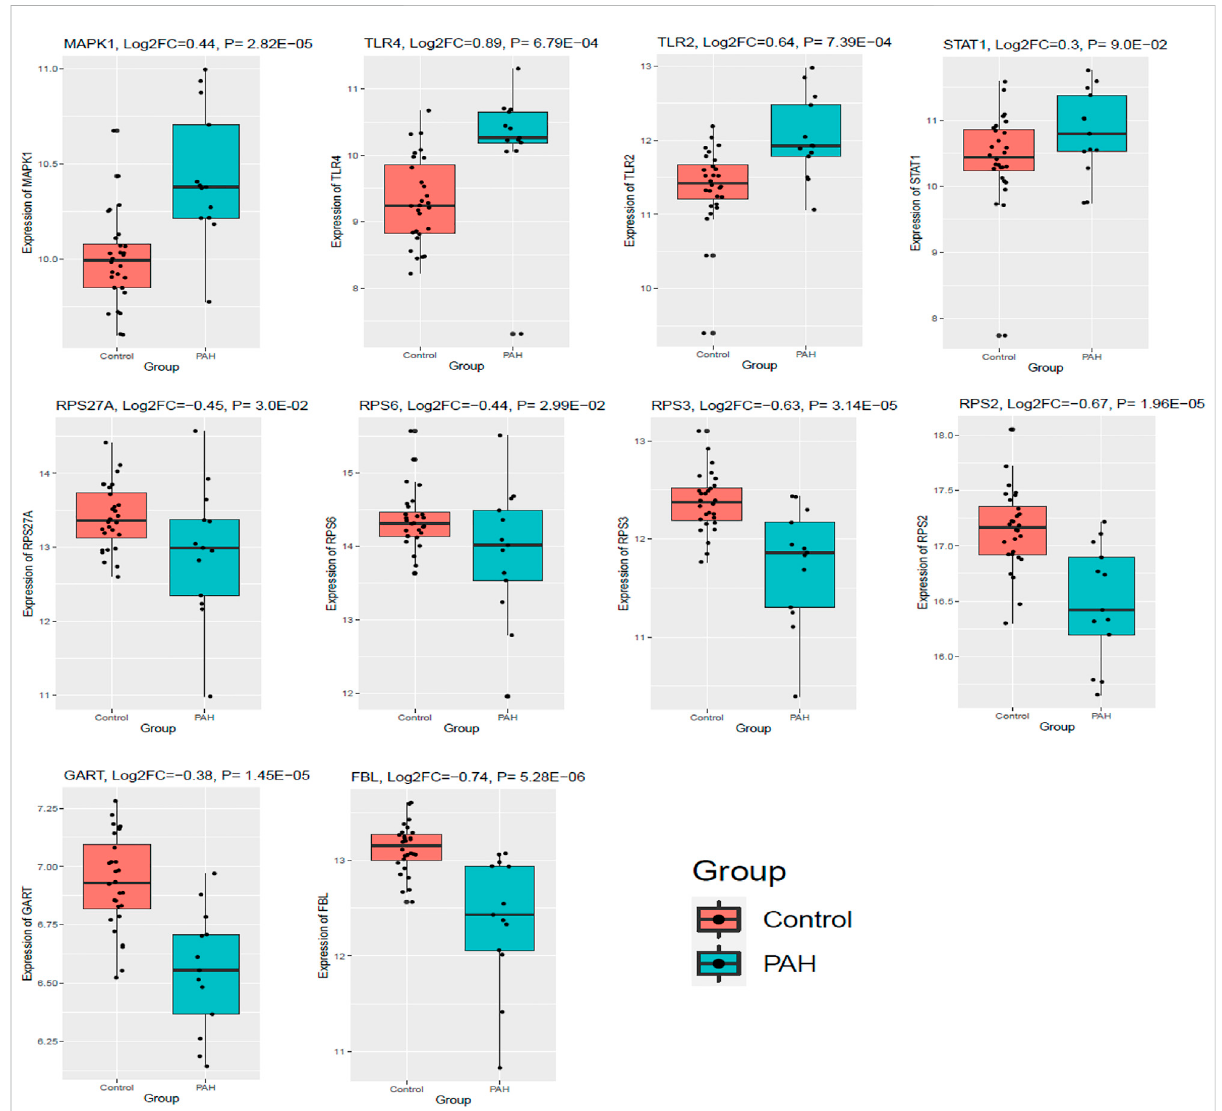
FIGURE 10 ThetoptenhubgeneswereexpressedinanindependentcohortofbloodwithPAH.GSE38267( n =41)wasutilizedtovalidatetheexpressionof the top ten hub genes. Data were normalized into the Log2